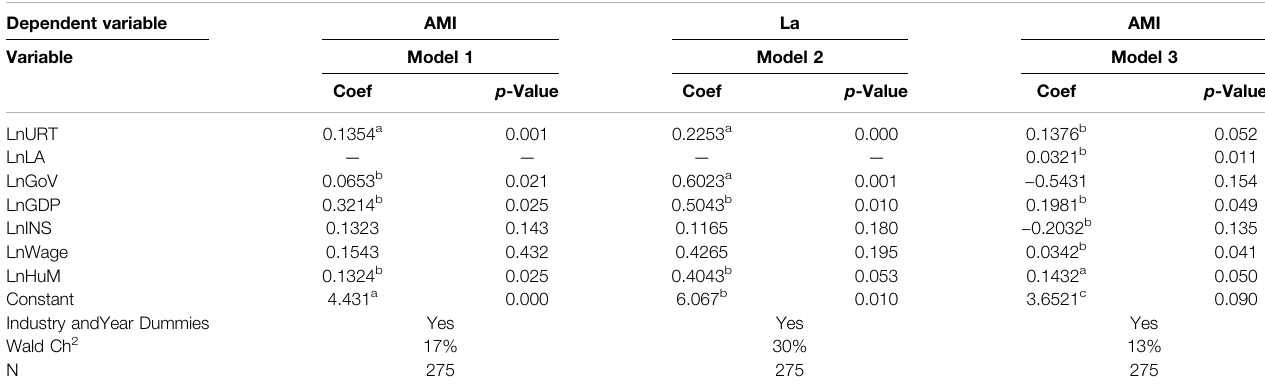
TABLE 3 | Robustness